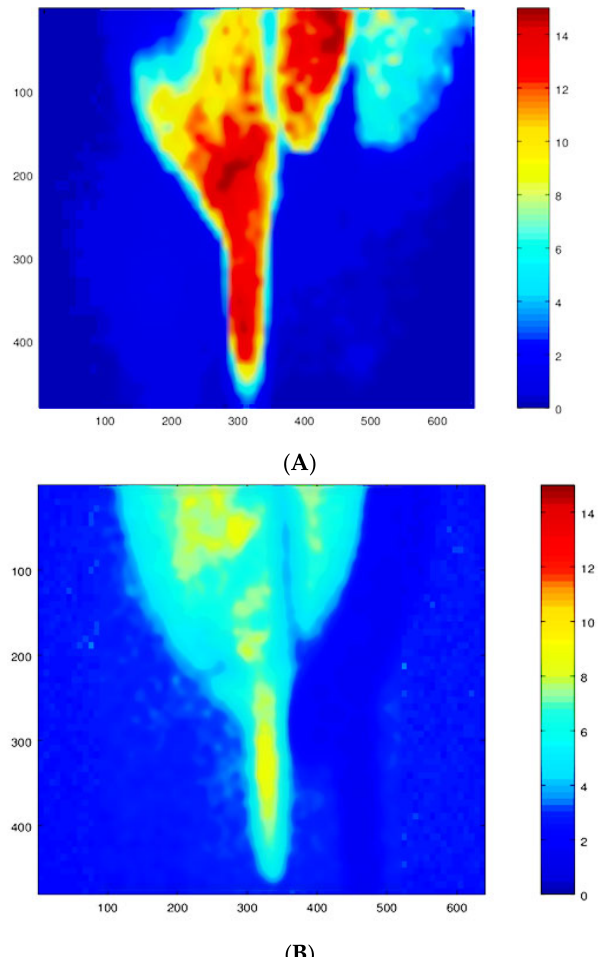
Figure 9. Maps of the DLS activity obtained using the SD index on a germinating maize seedling obtained with 660 nm laser illumination and with 780 nm illumination. ( A ) Typical SD map of a maize seedling obtained using 660 nm laser illumination. ( B ) Typical SD map of a maize seedling obtained using 780 nm laser illumination. Blue indicates the lowest activity and red the highest ac ‐ tivity.